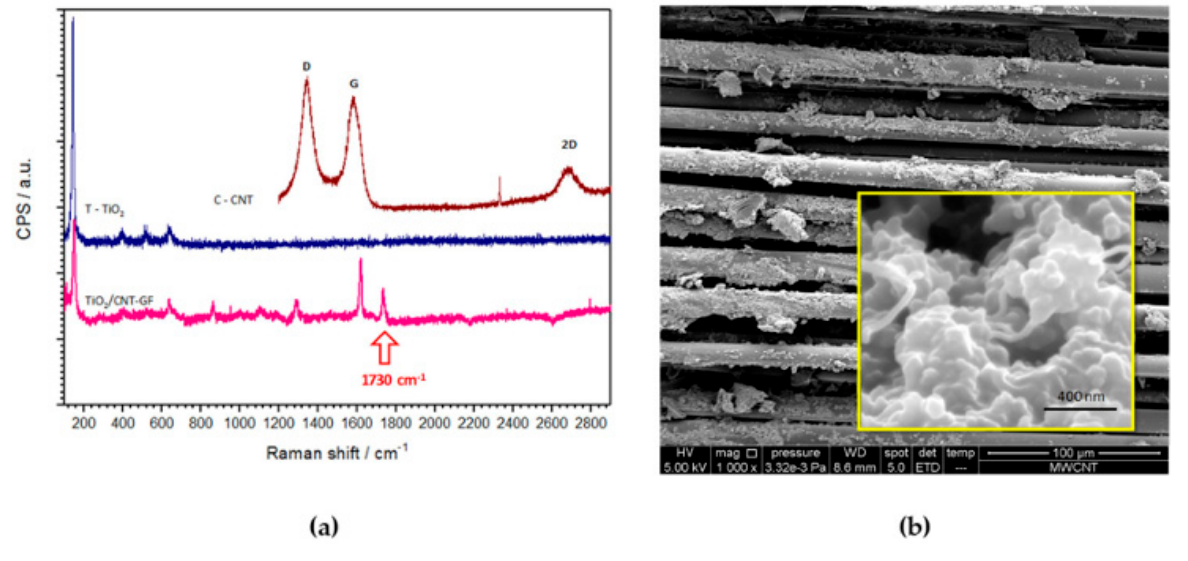
Figure 1. ( a ) Raman spectra of the photocatalytic constituents and composite film on glass fiber mesh; ( b ) SEM image of TiO 2 /CNT at 1000 magnification and 200,000× (given as embedded figure) [52].